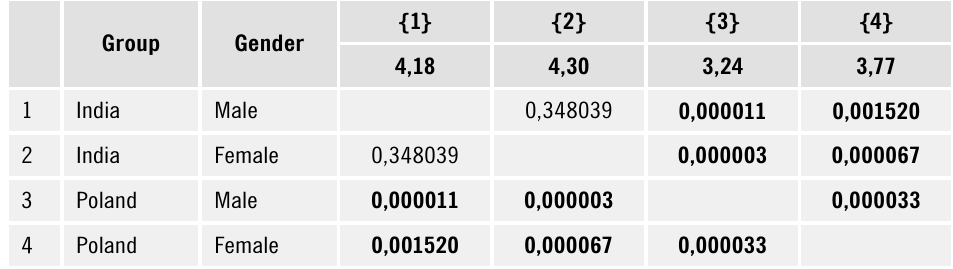
Table 10. Descriptive statistics of post-hoc Duncan difference test between respondents of different gender and nationalities in the TA dimension